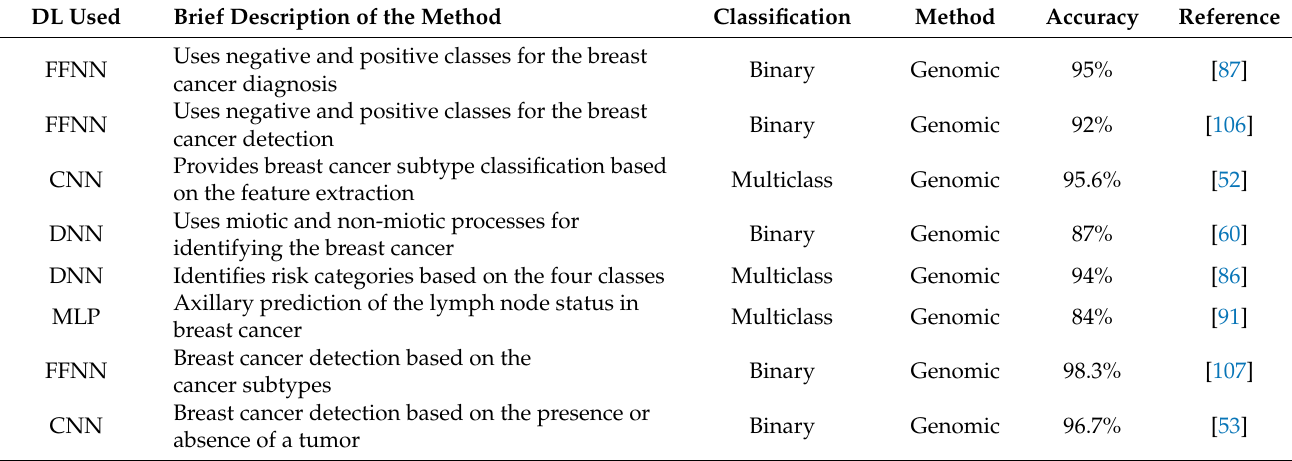
Table 5. Models used for gene sequencing data in selected